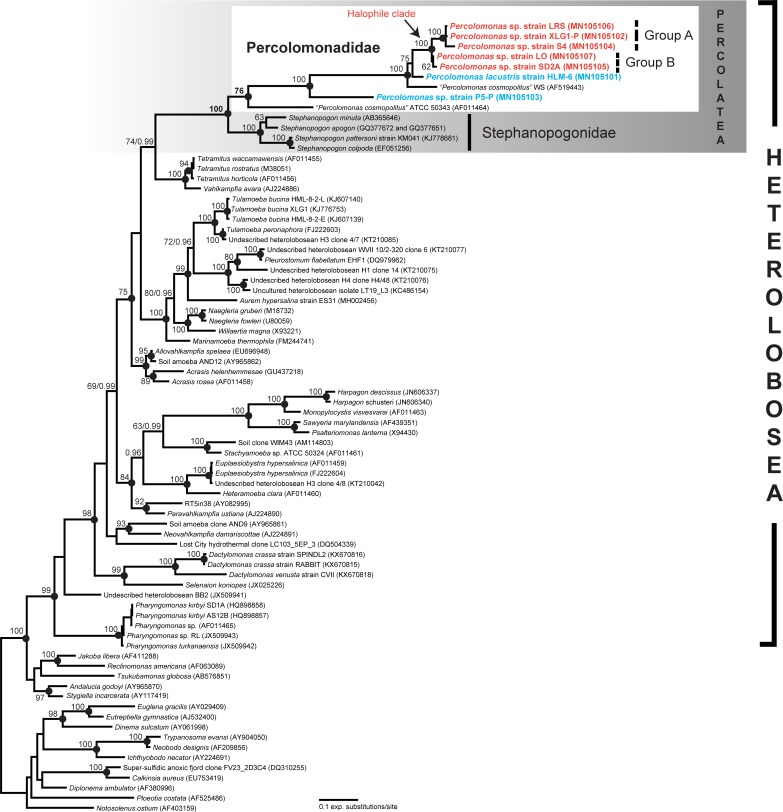
Maximum likelihood phylogenetic tree of 18S rRNA gene sequences from Percolomonas strains, other representative heterolobosean species, and outgroups (i.e. Euglenozoa, Jakobida, and Tsukubamonas globosa).Bootstrap support values (> 60%) are shown at the nodes. Solid circles represent a Bayesian posterior probability of 1 (posterior probability < 0.95 not shown). Note that ‘Group A’ and ‘Group B’ in Percolomonadidae (marked in red) together represent the putative halophilic Percolomonas clade.